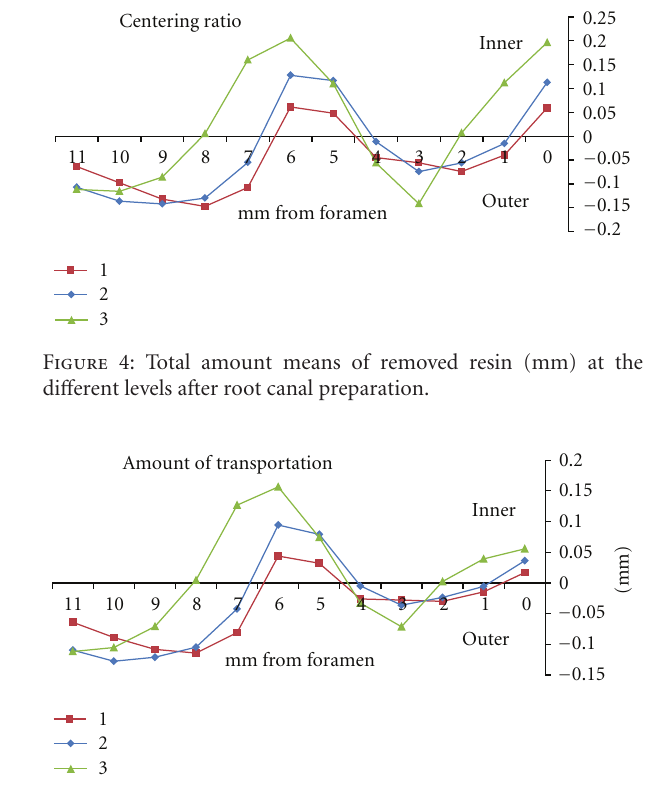
Figure 5: Centering ratio means at the di ff erent levels after root canal